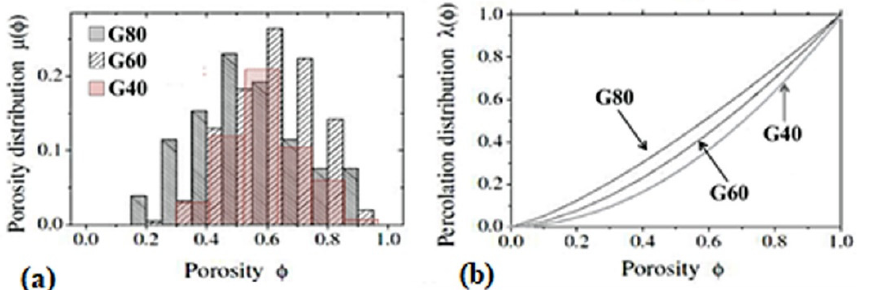
Figure 2. The local porosity distribution ( a ) and the local percolation probability ( b ) as a function of the porosity for samples GMA/DVB 80:20 (G80), GMA/DVB 60:40 (G60) and GMA/DVB 40:60 (G40), deduced by dielectric relaxation measurement.